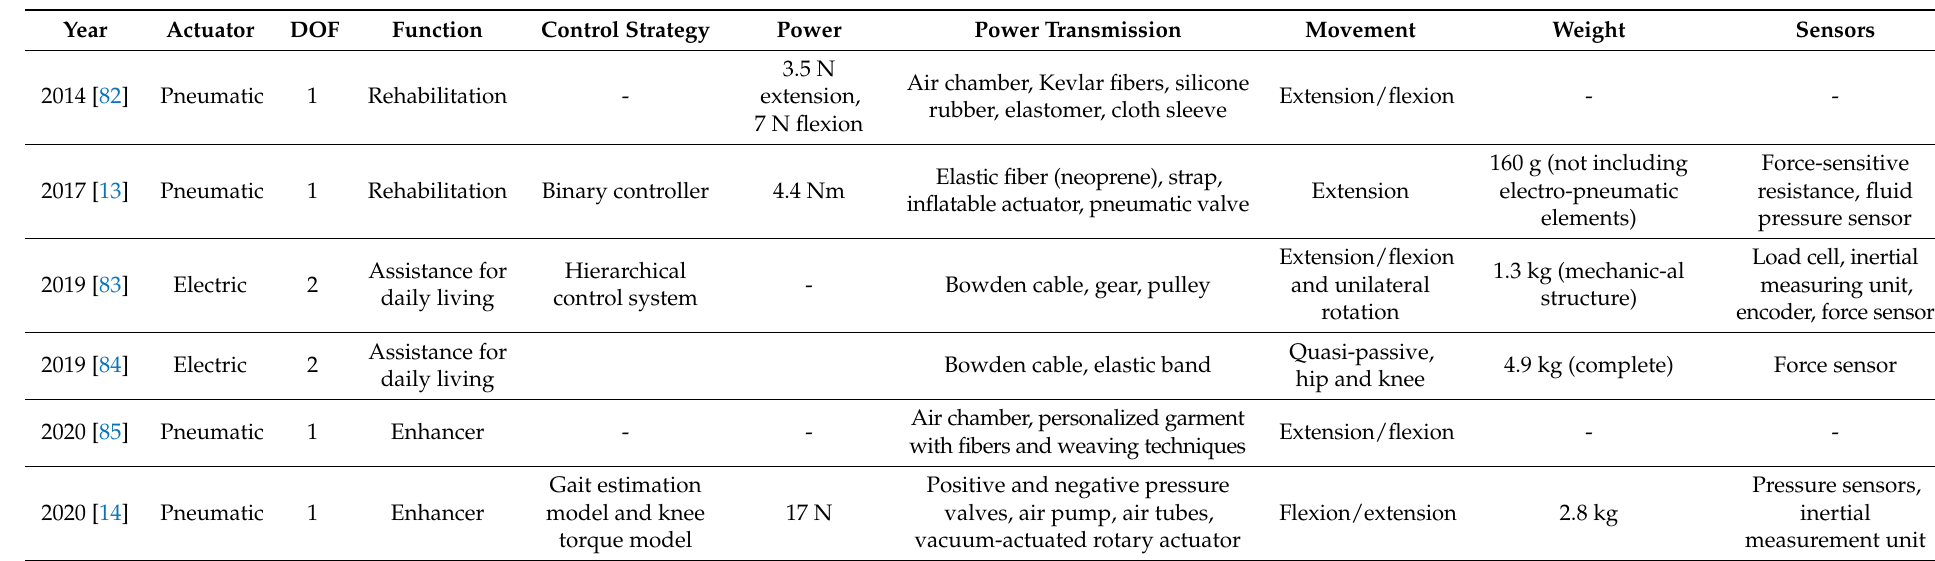
Table 6. Development of soft exoskeletons for the